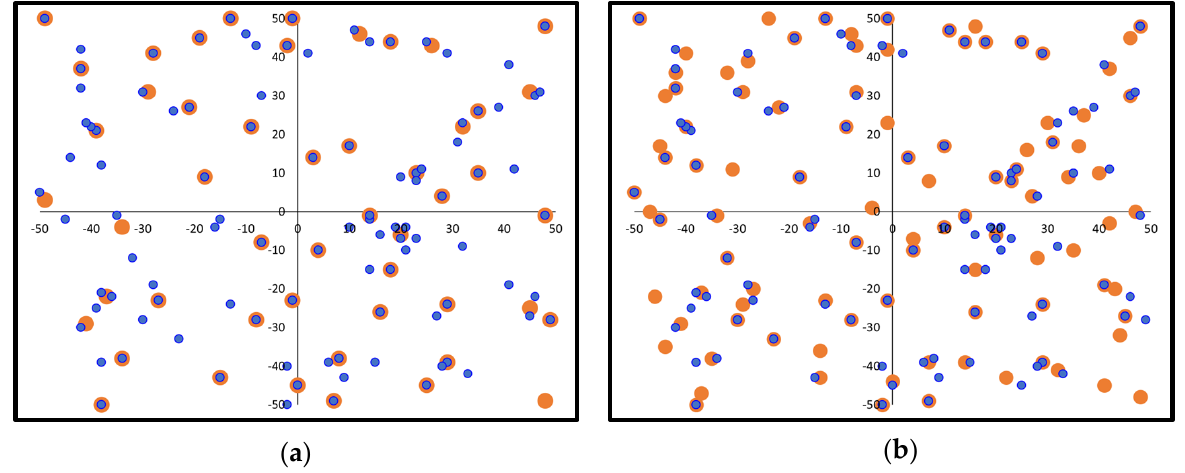
Figure 11. Indicative charging station deployment optimization results for Case Study 7: ( a ) 50-station charging network; ( b ) 100-station charging network (demand points in blue color, charging stations in orange color).